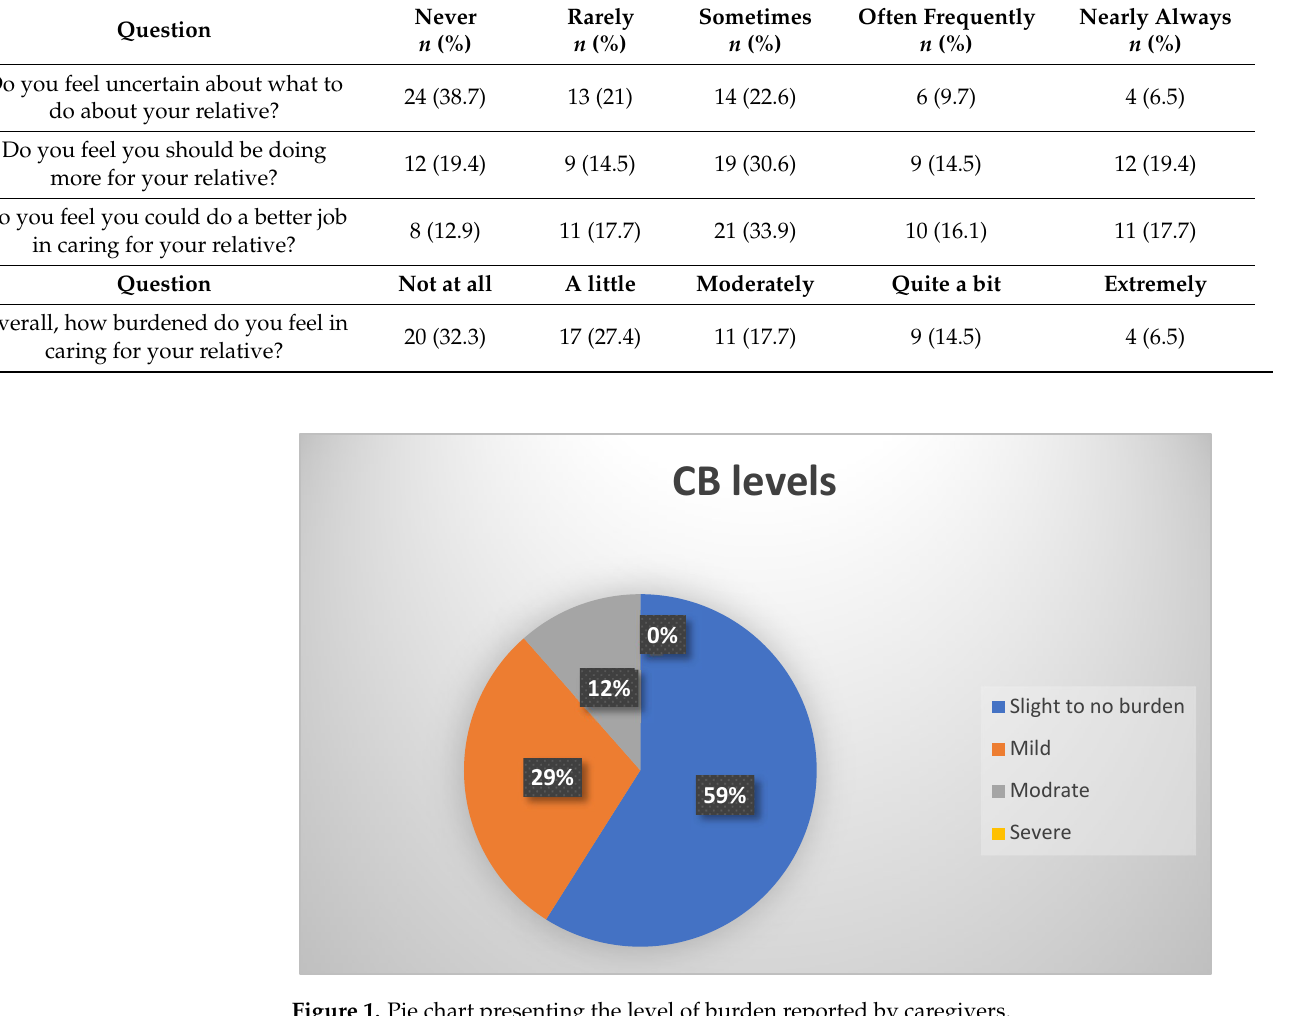
Figure 1. Pie chart presenting the level of burden reported by caregivers. Table 2. Responses of caregivers to ZBI items .